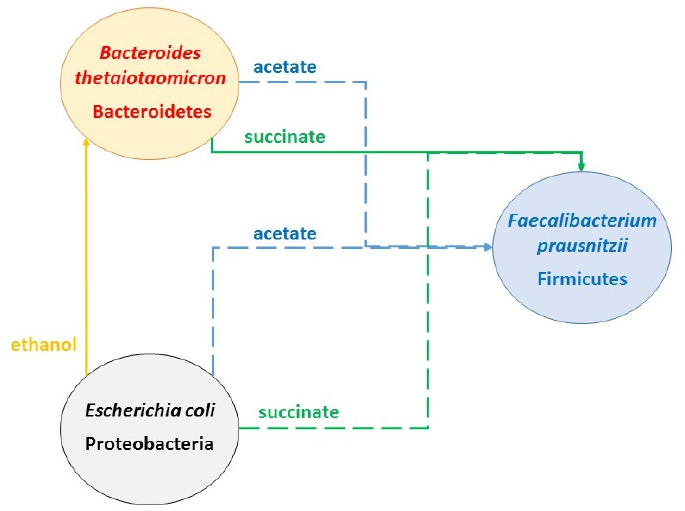
Figure 7. Effect of key cross-feeding relationships on community stability. Solid lines represent relationships required for stability: F. prausnitzii consumption of succinate produced by B. thetaiotaomicron , F. prausnitzii consumption of acetate produced by either B. thetaiotaomicron or E. coli , and B. thetaiotaomicron consumption of ethanol produced by E. coli . Dashed lines represent relationships that are not required for stability but may impact species